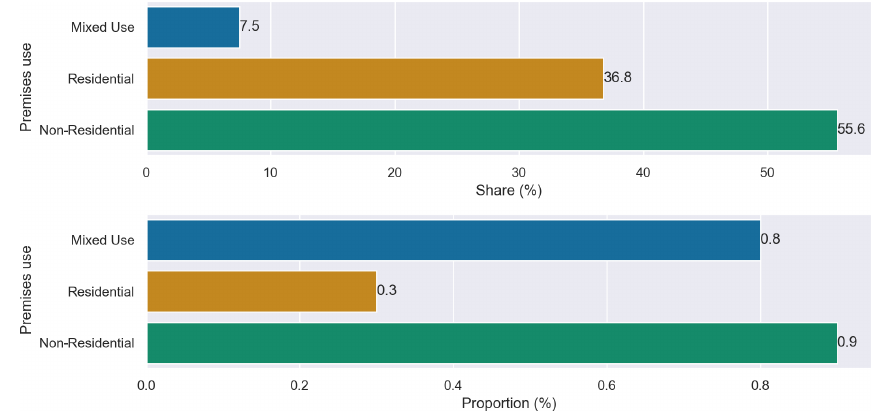
Figure 11. Share and proportion of green roofs for different building uses. Most green roofs are on non-residential buildings. Mixed use refers to buildings comprising both residential and non-residential uses.